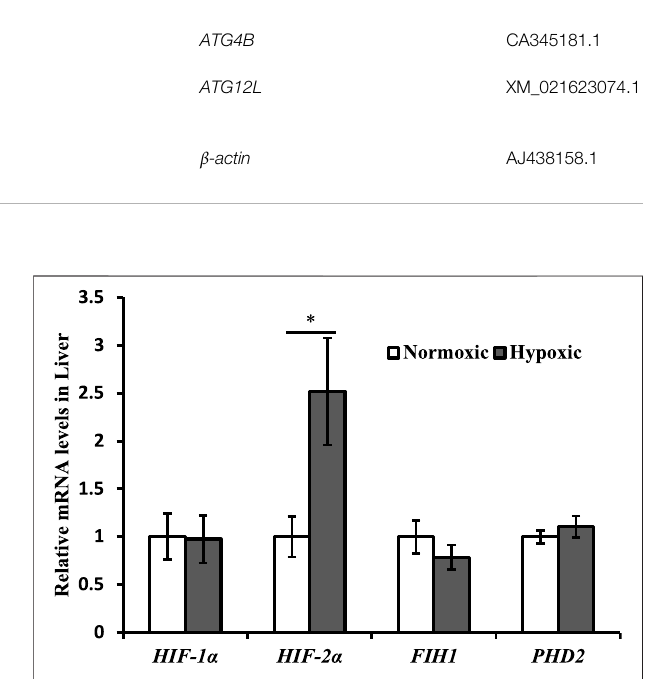
FIGURE 1 | Effect of acute hypoxic stress on the expression of the hypoxia-related genes in the liver of triploid rainbow trout ( n = 6; HIF-1 α , hypoxia-inducible factor 1 α ; HIF-2 α , hypoxia-inducible factor 2 α ; FIH1 , factor inhibiting hypoxia-inducible factor 1; PHD2 , egl nine 1-like protein). Asterisks indicate the signi fi cant difference ( t -test; * p < 0.05; ** p <